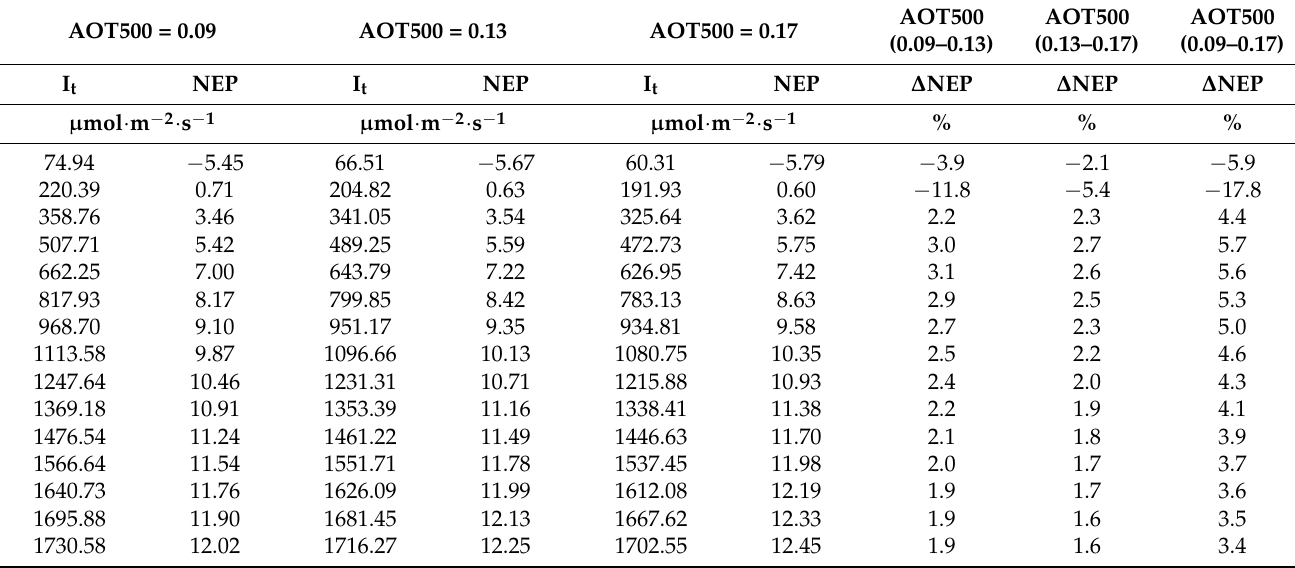
Table 3. Net ecosystem production (NEP) under different values of aerosol optical thickness at 500 nm (AOT500) and total photosynthetic photon flux density (I t